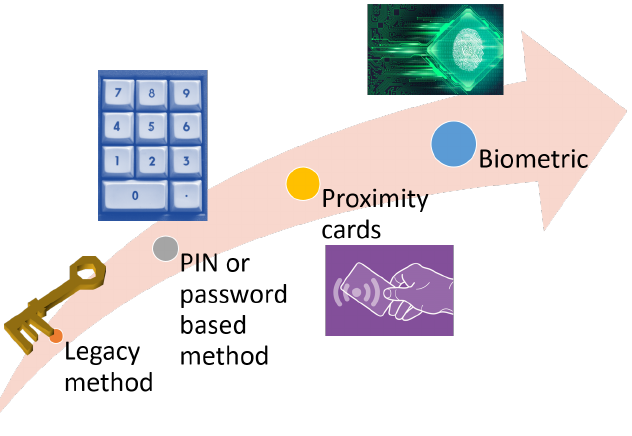
Figure 2. Evolution of access control systems from metal keys to biometric